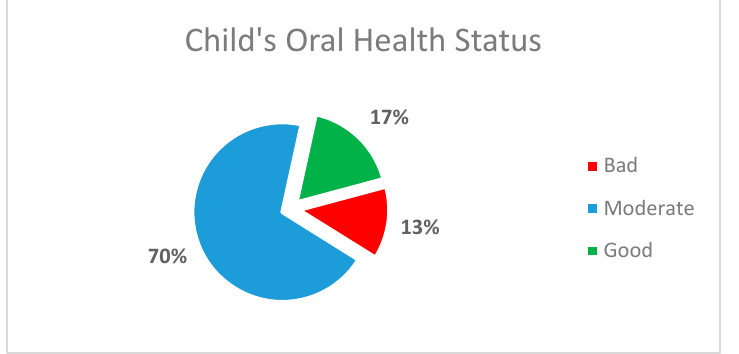
Figure 4. Distribution of the sample of children according to oral health status ( n = 23).